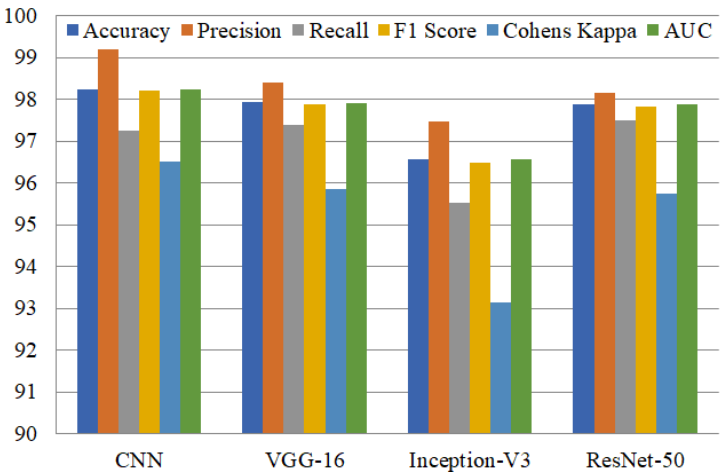
Figure 5. Comparison of individual models for performance evaluation